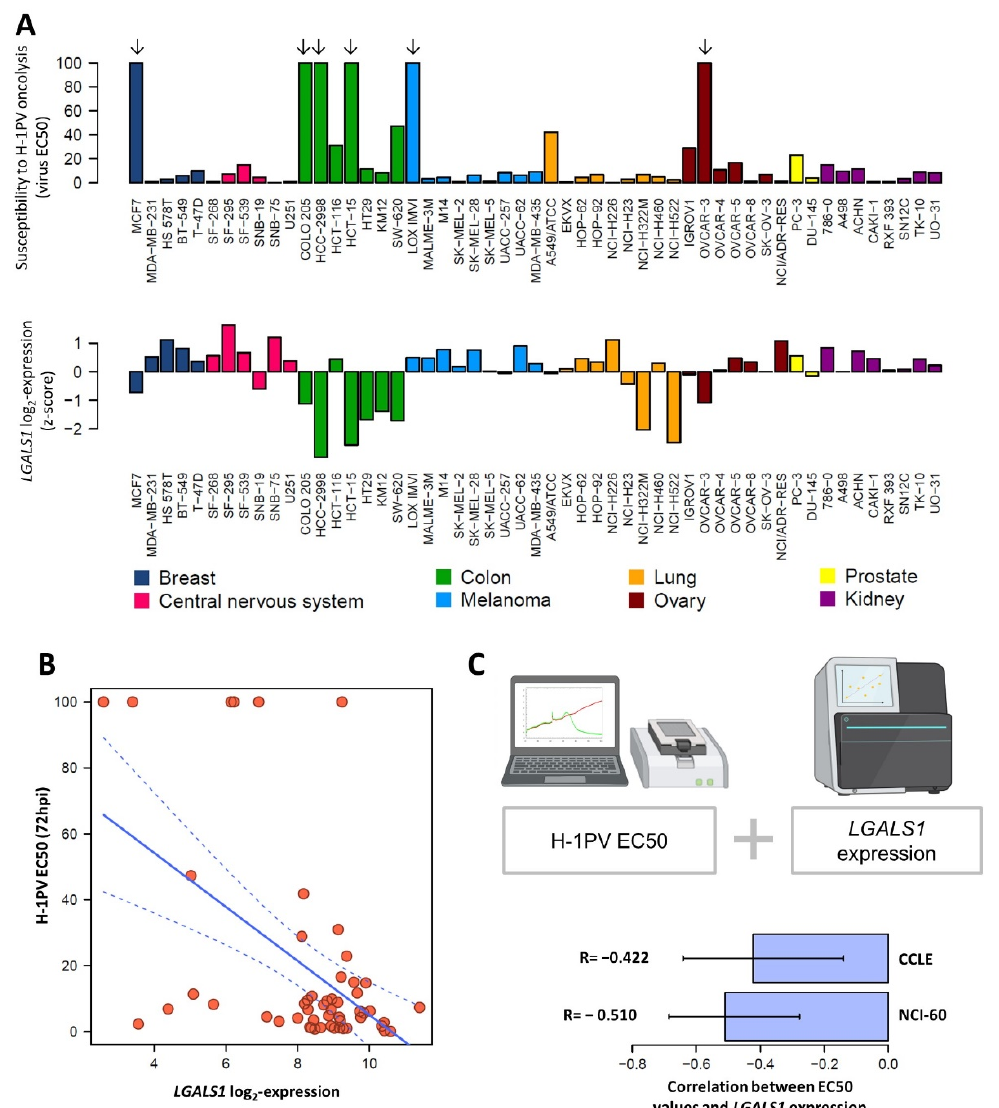
Figure 8. Correlation between LGALS1 gene expression of cancer cell lines and their susceptibility to H-1PV-induced oncolysis. ( A ) LGALS1 gene expression was retrieved from the National Cancer Institute (NCI)-60 database. Fifty-three cancer cell lines from the NCI-60 panel were tested for their susceptibility to H-1PV infection by xCELLigence. H-1PV EC50 values were calculated as the viral MOI that kills 50% of the cell population at 72 h post-infection (72hpi), measured by xCELLigence (see also [14]). Six cancer cell lines (MCF7, COLO 205, HCC-2998, HCT-15, LOX IMVI, OVCAR-3 (indicated by arrows) were found to be resistant to cell lysis even at the maximum tested concentrations of H-1PV (MOI 50 pfu/cell). Therefore, as EC50 values could not be calculated for those cell lines, their values were arbitrarily fixed as 100; ( B ) LGALS1 expression versus H-1PV EC50. Each blue dot corresponds to a cell line and the grey line corresponds to a linear regression. ( C ) LGALS1 levels are moderately anti-correlated with H-1PV EC50. LGALS1 gene expression measurements were retrieved from the NCI-60 (53 cell lines) and Cancer Cell Line Encyclopedia (CCLE) (52 cell lines). Bar plot depicts the correlation between the gene expression from each dataset and the EC50 values (Pearson’s correlation). Significant anti-correlation was observed for both NCI-60 and CCLE datasets with R = –0.510, C.I. (–0.685, –0.277), p < 0.001 and –0.422, C.I. (–0.641, –0.139), p < 0.01 respectively (in both cases, the null hypothesis: R = 0).